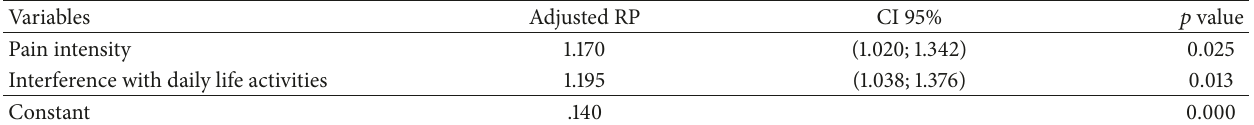
Table 4: Logistic regression model and factors associated with chronic pain as a function of